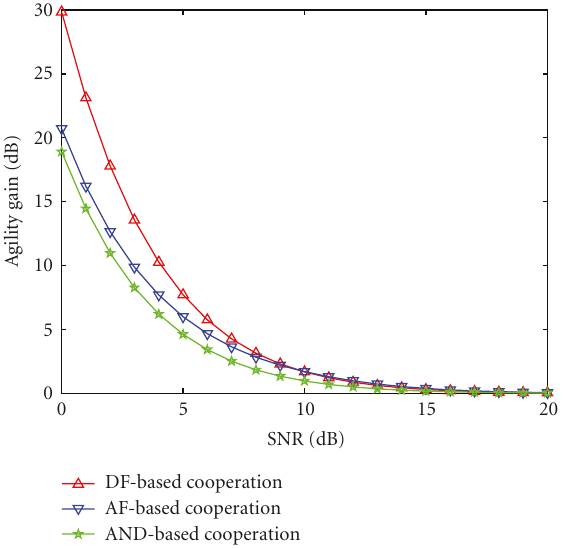
Figure 4: Agility gain versus T-SNR with α = 0 . 001, σ 2 η = 5dB and μ = 10dB, where η = 20log 20log ( σ 21 /σ p 1 ). 10